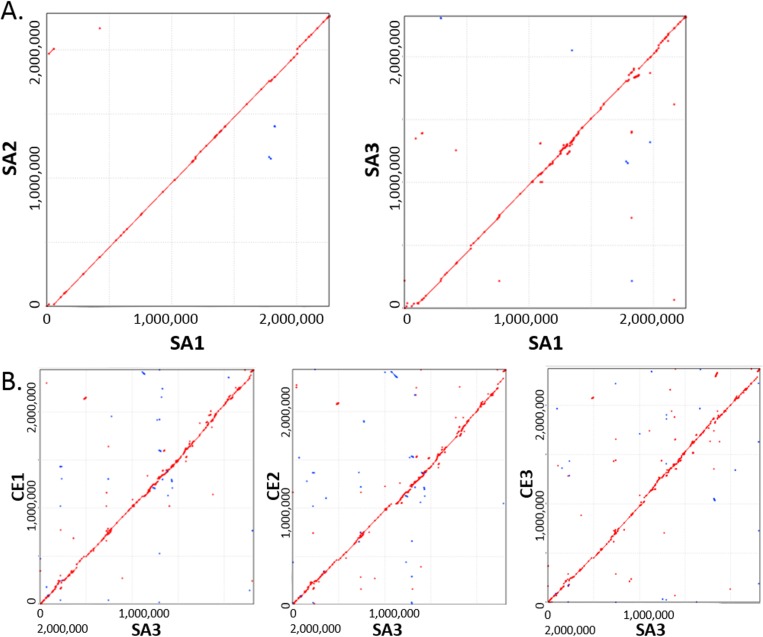
Synteny Plots of EC Chromosomes.Pathogenic EC genotypes (determined by PFGE) cluster tightly together compared to commensal EC. Genomes of pathogenic strains SA1, SA2, and SA3 are highly syntenic (A. SA1:SA2; B. SA1:SA3) which confirms clonality of these strains at high resolution. However, when compared to SA3, commensal strains CE1, CE2, and CE3 are much more diverse in genome content and arrangement (C. SA3:CE1; D. SA3:CE2; E. SA3:CE3).